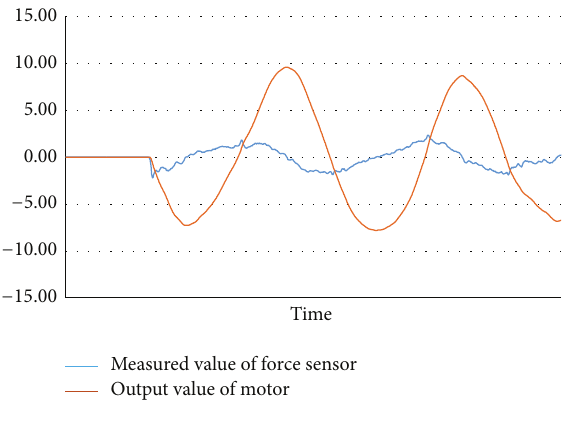
Figure 9: Low-speed